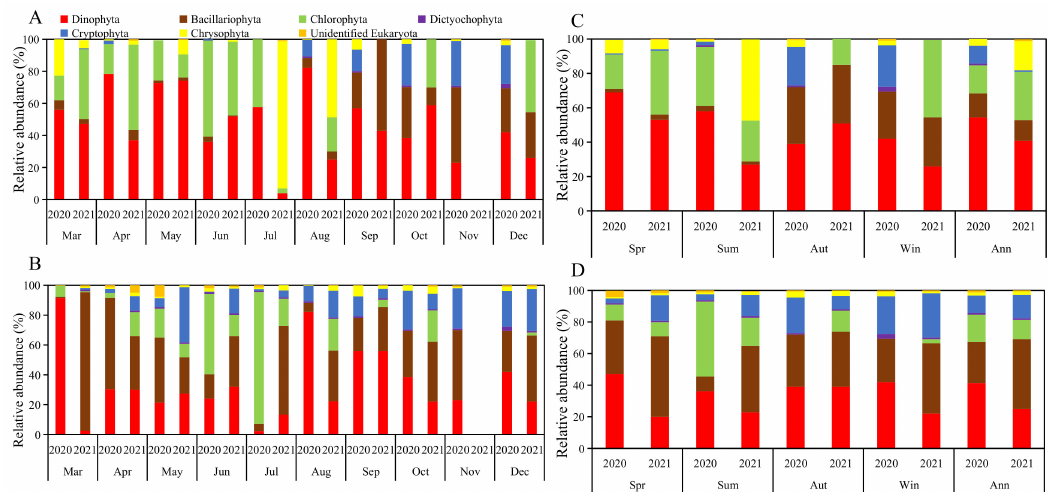
Figure 3. The biomass proportion of various groups of phytoplankton in 2020 and 2021: ( A ) monthly in the stomachs; ( B ) monthly in the water; ( C ) seasonal in the stomachs; ( D ) seasonal in the water.